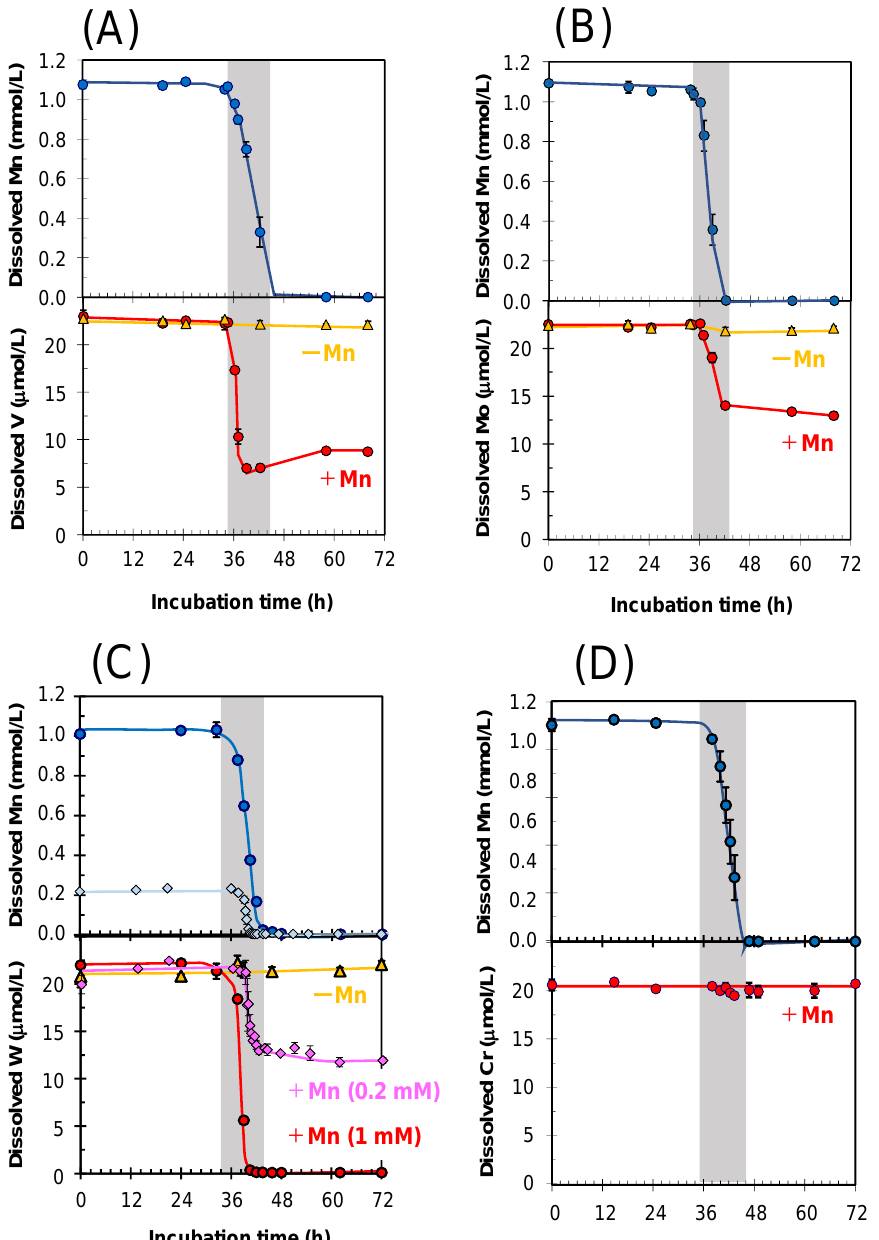
Figure 1. Sequestration of ( A ) V(V), ( B ) Mo(VI), ( C ) W(VI) (~20 µM) synchronized with biogenic Mn oxidation (~1 mM, and ~0.2 mM for W(VI)) during the incubation of Acremonium strictum KR21-2 in HAY liquid media (20 mM HEPES buffer at pH 7.0). No significant sequestration was observed when no Mn 2+ was supplemented. ( D ) Sequestration of Cr(VI) was negligible even when the biogenic Mn oxide was formed. Shadows indicate the timing of biogenic Mn oxide formation typically 34–46 h of the incubation. The error bars represent the standard deviation ( n = 3). There were no significant changes in dissolved V(VI), Mo(VI), and W(VI) during incubation when MnSO 4 was not supplemented (Figure 1A–C), indicating that the BMO formation mediated the sequestrations. Consequently, the sequestration on fungal hyphae (biomass) was negligible for all oxyanions used in this study. Sequestration efficiency was the highest for W(VI) at >99%, where the initial W(VI) at 22.0 ± 0.2 µ M decreased to 0.06 ± 0.00 µ M (Figure 1C). Sequestration efficiency of W(VI) at the initial concentration of 19.2 ± 1.0 μM was still high at 42% even when the MnSO 4 -supplementation was lower at 0.22